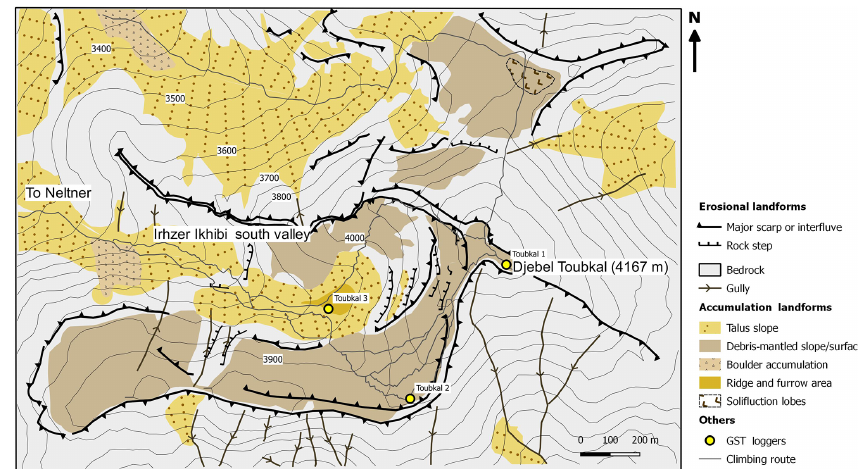
Figure 2. Geomorphological sketch map of the Toubkal massif (see legend).